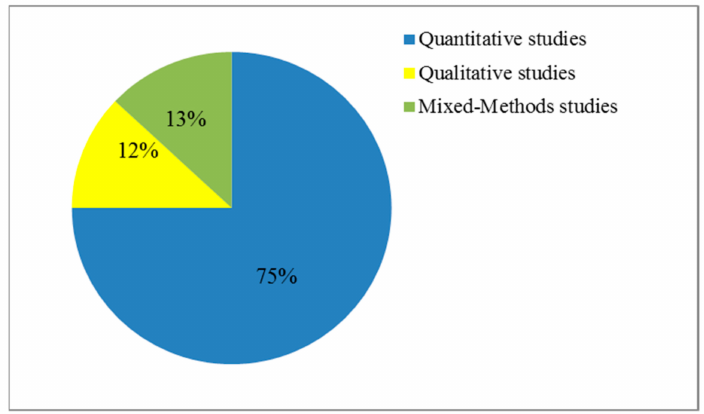
Figure 2. Categorization of